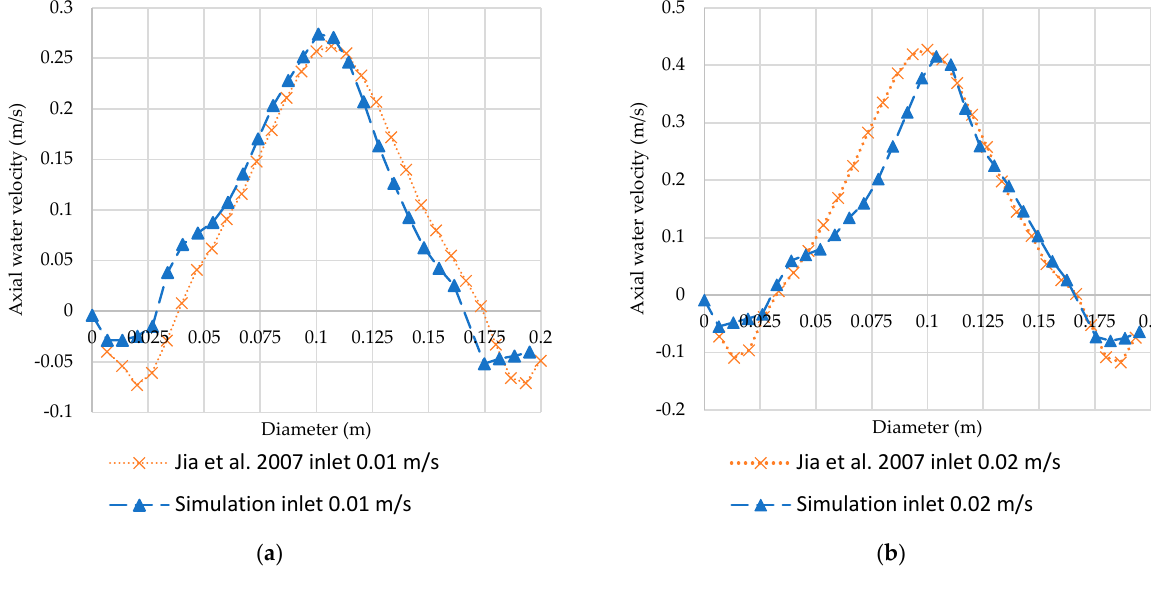
Figure 14. Comparison of CFD model to literature values of Jia et al. Ref. [74]: ( a ) inlet velocity of 0.01 m/s and ( b ) inlet velocity of 0.02 m/s.